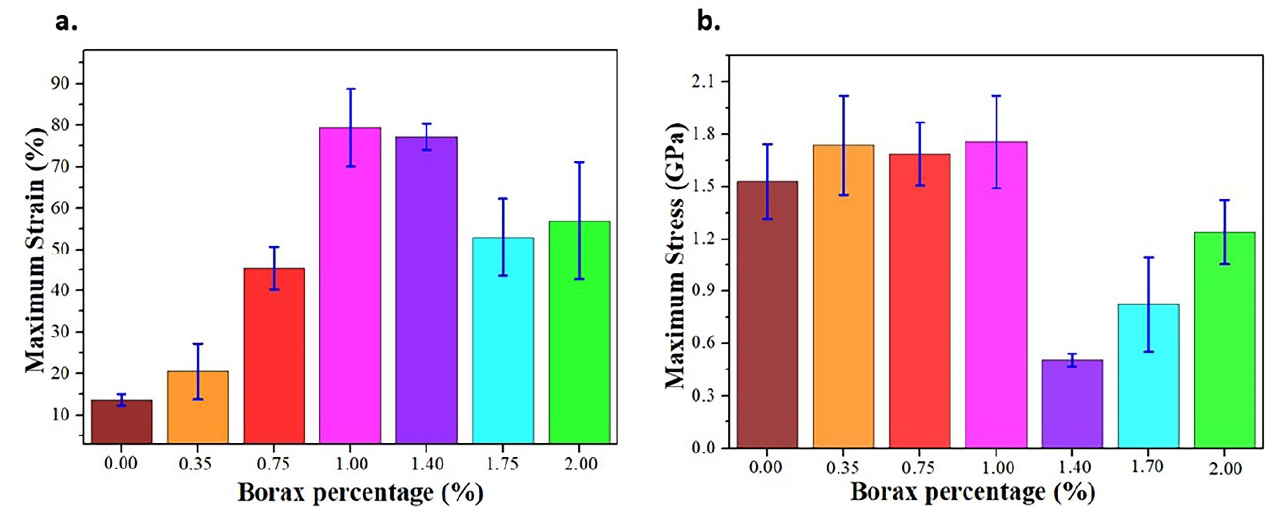
Figure 6. Sample’s maximum strain ( a ) and maximum stress ( b ) measured at constant velocity configuration (2 mm/min).